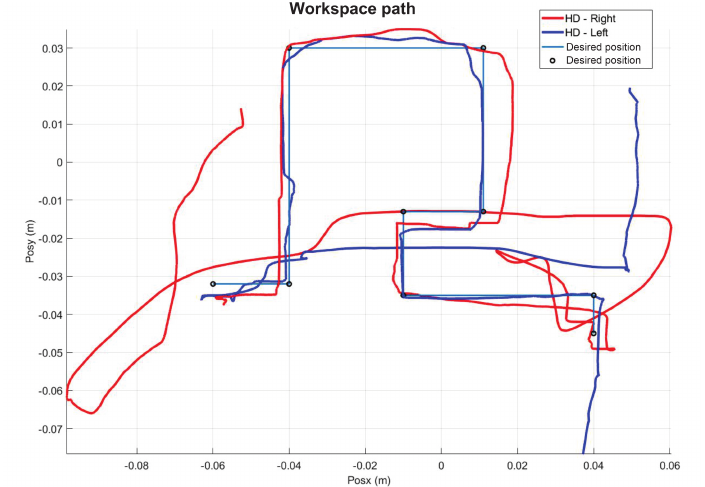
Figure 14. Initial operating position by the user.